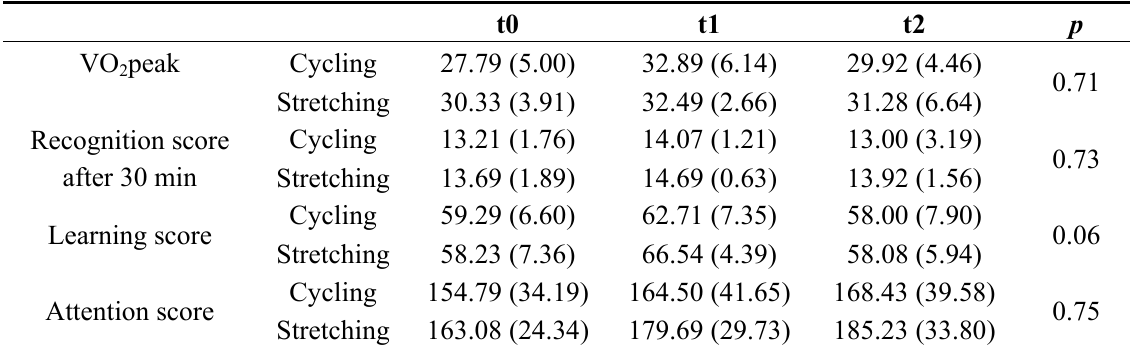
Table 2. Cardiovascular fitness and cognitive variables separately for participants of the cycling training vs . stretching training (mean with standard deviation in